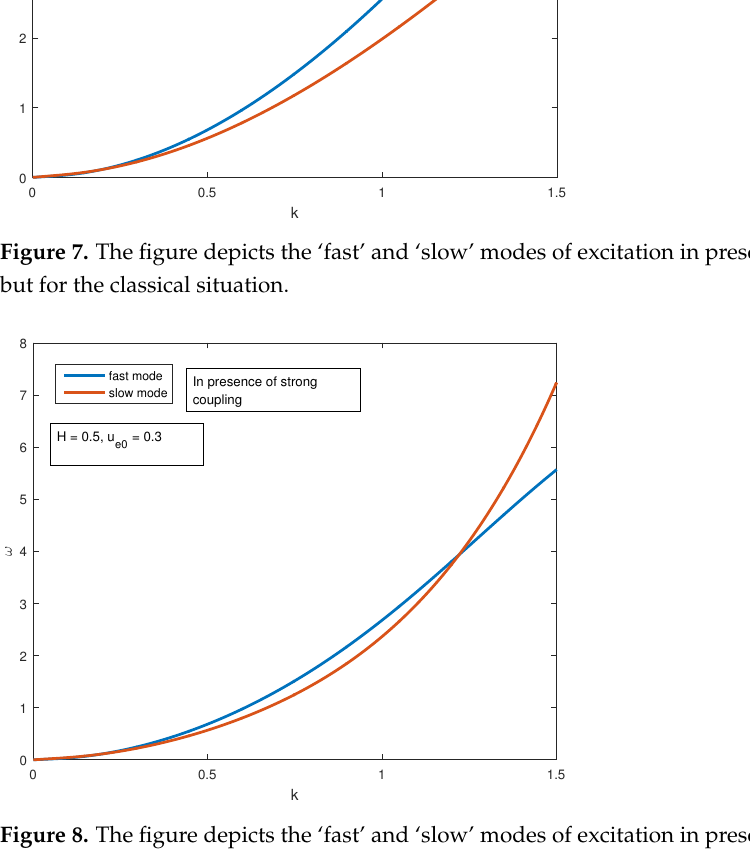
Figure 8. The figure depicts the ‘fast’ and ‘slow’ modes of excitation in presence of strong coupling in the quantum